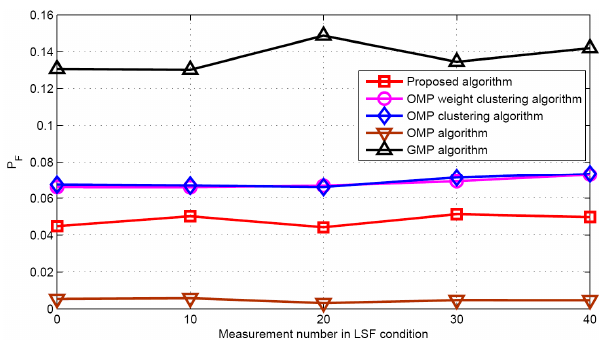
Figure 18. False alarm rate in LSF condition.